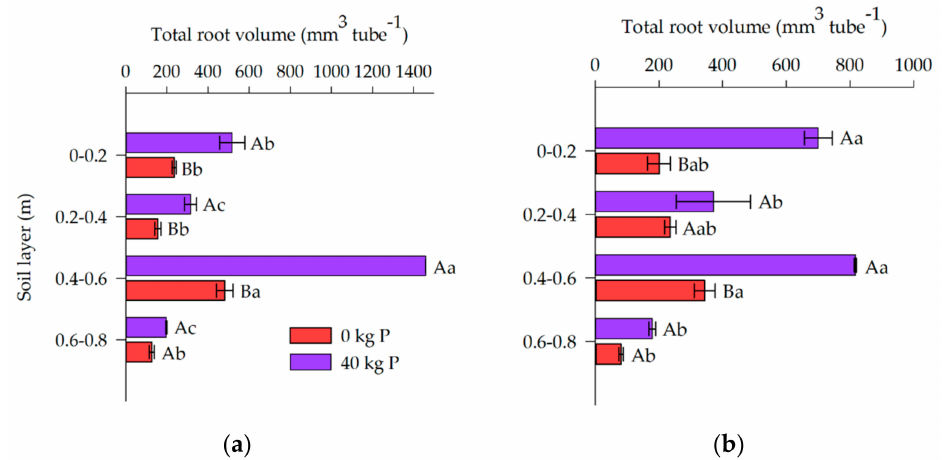
Figure 7. Total living root volume (mm 3 tube − 1 ) in H. heptaphyllus plants subjected to applications of 0 and 40 kg P ha − 1 as observed in 0–0.2 m, 0.2–0.4 m, 0.4–0.6 m and 0.6–0.8 m layers at 18 ( a ) and 36 months after transplant ( b ). ( a , b ) The uppercase letters compare P rate considering the same soil layer, while lowercase letters compare soil layers based on the Tukey test ( p < 0.05), since the interaction was significant at 5% based on two-way analysis of variance (ANOVA). Horizontal bars represent the standard error of three repetitions.